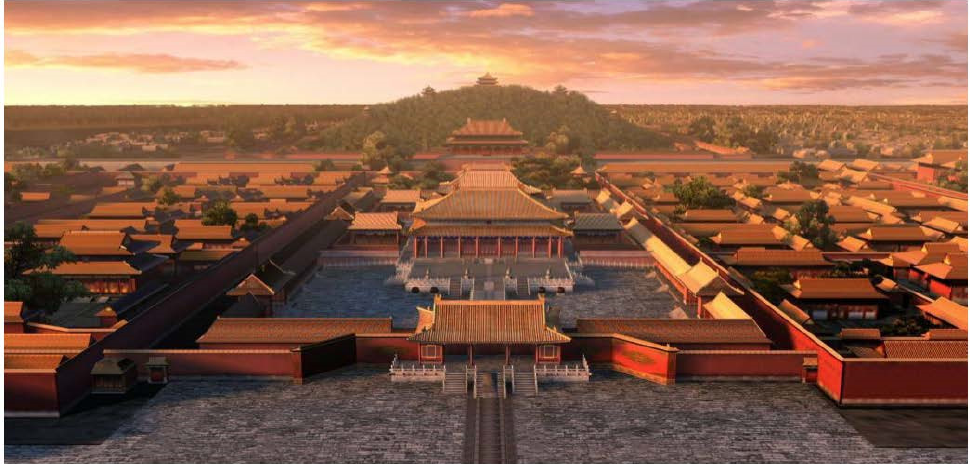
Figure 1. The Forbidden City building and its periphery.